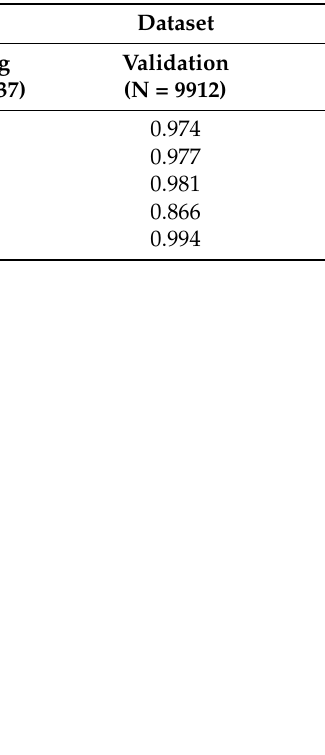
Table 4. Classification performance of the proposed signal quality assessment model using training, validation, and test datasets.